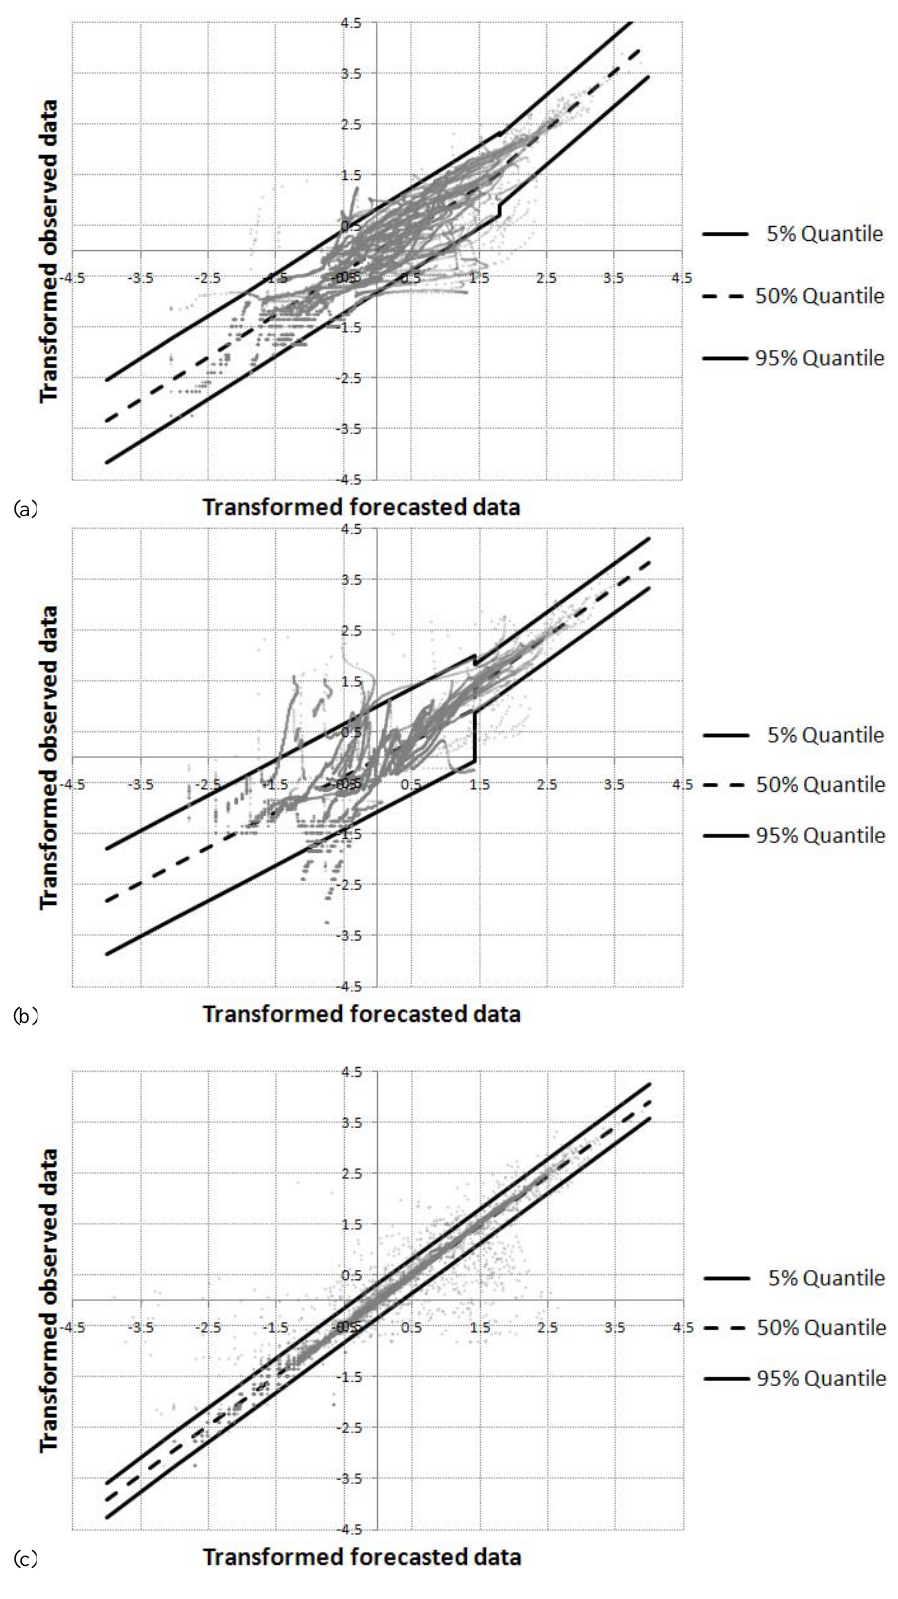
Fig. 11. Representation of the Normal Space obtained using the MCP with the TOPKAPI (a) , TETIS (b) and ANN (c) forecasts.